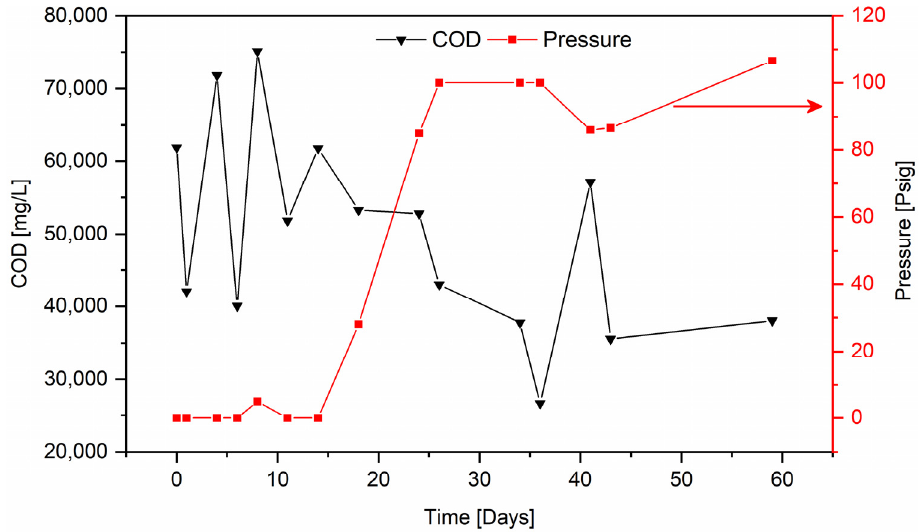
Figure 5. Variation of COD and pressure during digestion.